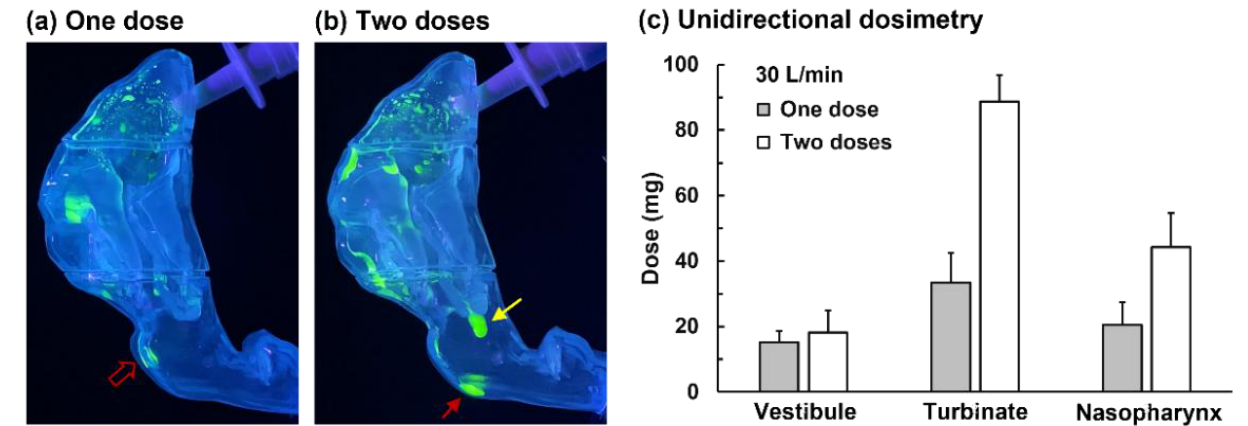
Figure 8. Nasal spray deposition distribution using unidirectional delivery in a supine position with a flow rate of 30 L/min with ( a ) one dose, ( b ) two doses, and ( c ) quantification of regional deposition fractions.